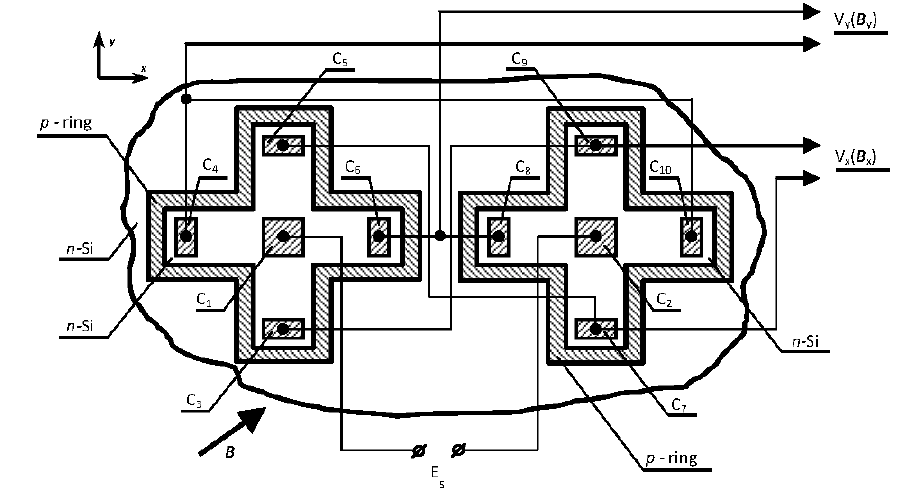
Figure 1. Schematic top-view of 2-D integrated Hall device. The simple design, original connection, inherent symmetry and deep p -ring drastically reduce the channels cross-talk and the offset is decreased